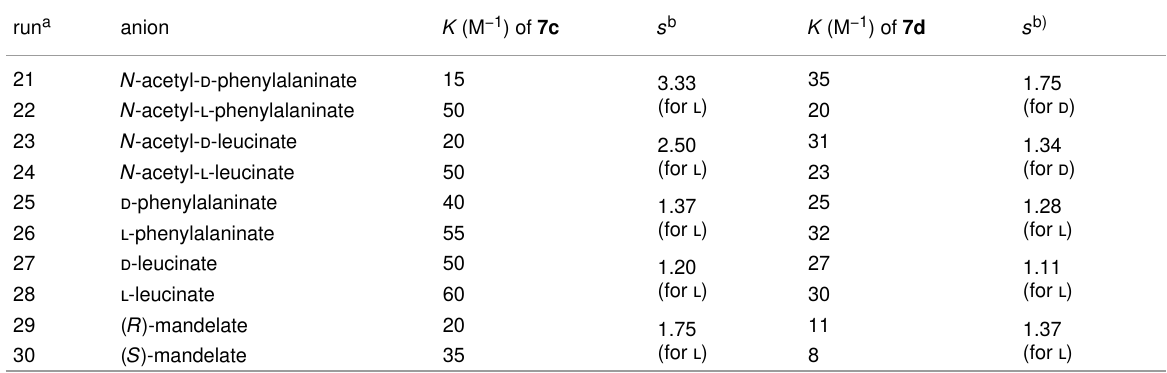
Table 3: Binding constants of the receptors 7c and 7d towards selected anions ( 1 H NMR titration, 400 MHz, DMSO- d 6 , 298 K).